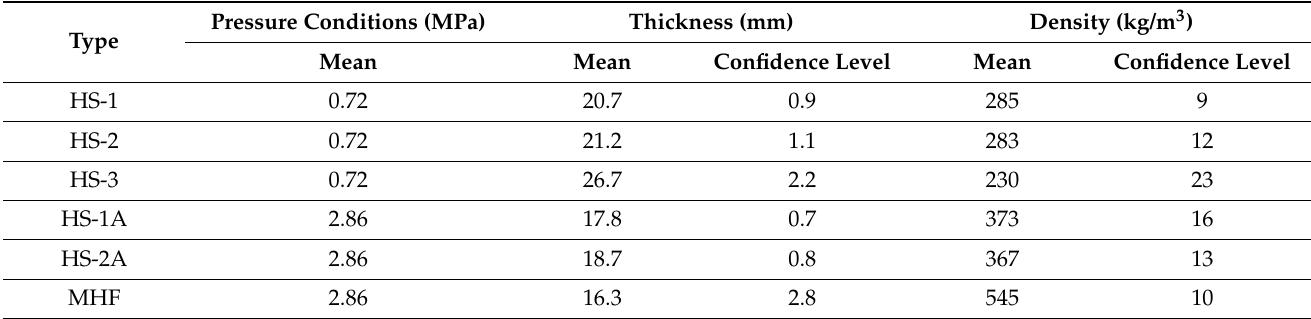
Table 2. Produced hemp shive particleboard mean values of the physical